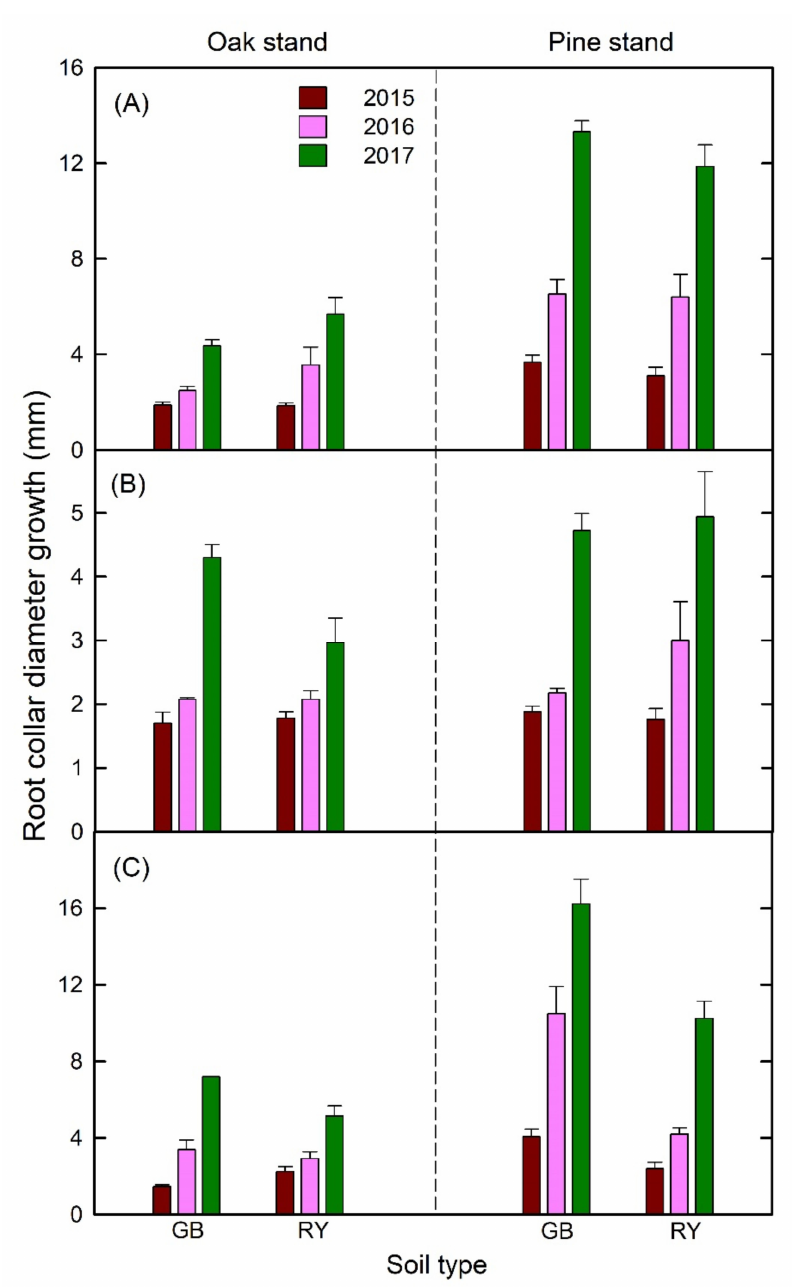
Figure 3. Root-collar-diameter growth of ( A ) Fraxinus rhynchophylla , ( B ) Pinus koraiensis , and ( C ) Zelkova serrata in different soil and forest stands from 2016 to